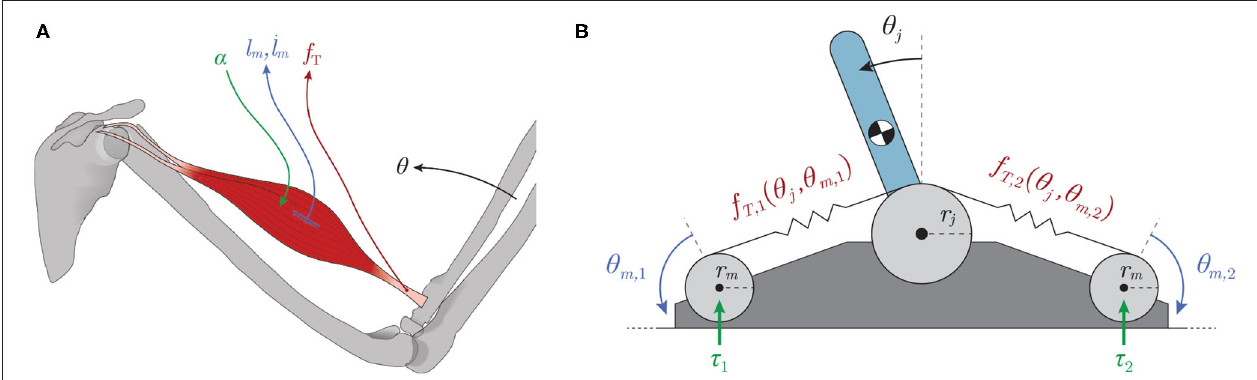
FIGURE 1 | (A) Types of mechanoreceptors present in a muscle. Muscles are activated by spinal α -motorneurons ( green ) and any subsequent muscle fascicle (i.e., individual muscle fiber) length changes and velocities are sensed by the muscle spindles ( l m & ˙ l m , blue ) while the Golgi tendon organs are responsible for detecting tendon tension ( f T , maroon ). (B) Schematic of a tendon-driven system with 1 kinematic DOF and 2 degrees of actuation (motors) that pull on tendons with nonlinear elasticity (creating a tension, f T , i ). The motors were assumed to be backdrivable with torques ( τ i ) as